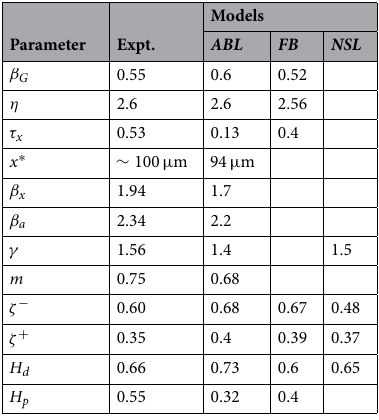
Table 2. Comparison of various exponents and cut-off scales derived experimentally 27,28 (Expt.) and numerically with the present, Arrhenius Based, fluctuating Line model (ABL), the Fiber Bundle model 30 (FB) and the Non-Subcritical fluctuating Line model 4,5